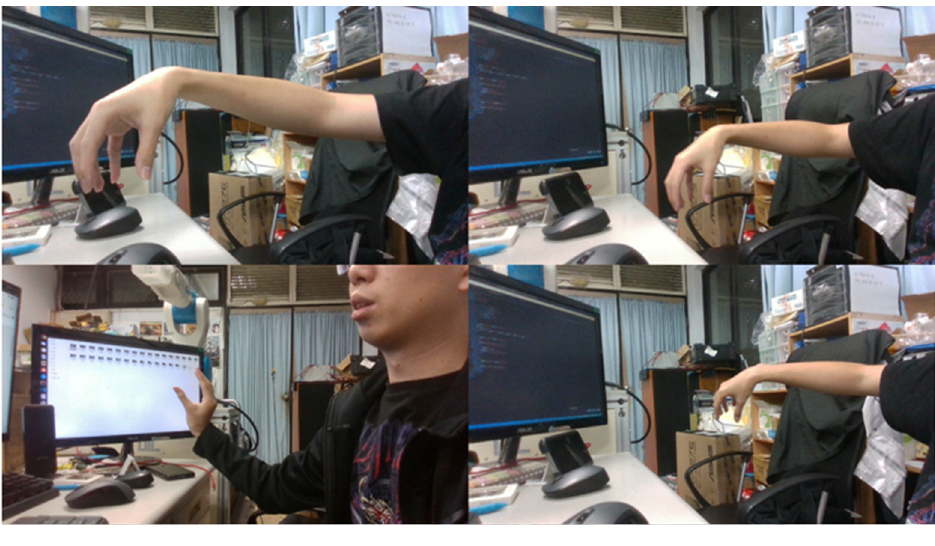
Figure 3. Wrist data collection.